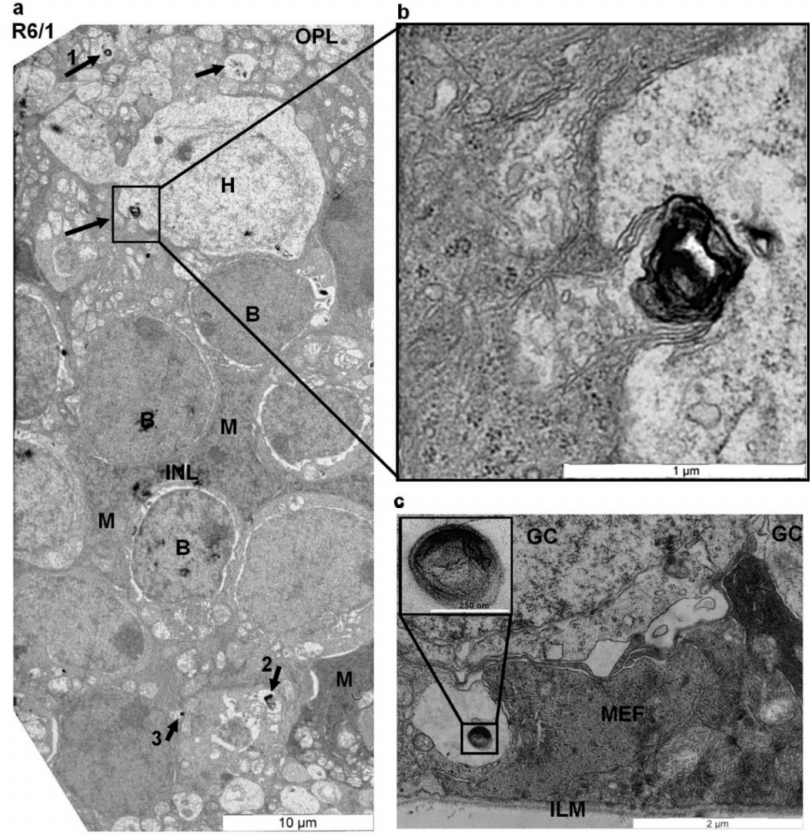
Figure 2. EM analysis of the inner retina of HD R6/1 mice. ( a , b ) Electron micrograph of the INL from 23-week-old R6/1 mice. ( b ) is a selection from ( a ). Cell nuclei in the INL are identified according to [50]. Myelinosomes (black arrows) are enclosed in vacuoles or discharged from cells displaying an osmiophilic cytoplasm and dark elongated nuclei ( a , b ), which is a characteristic of glial Müller cells